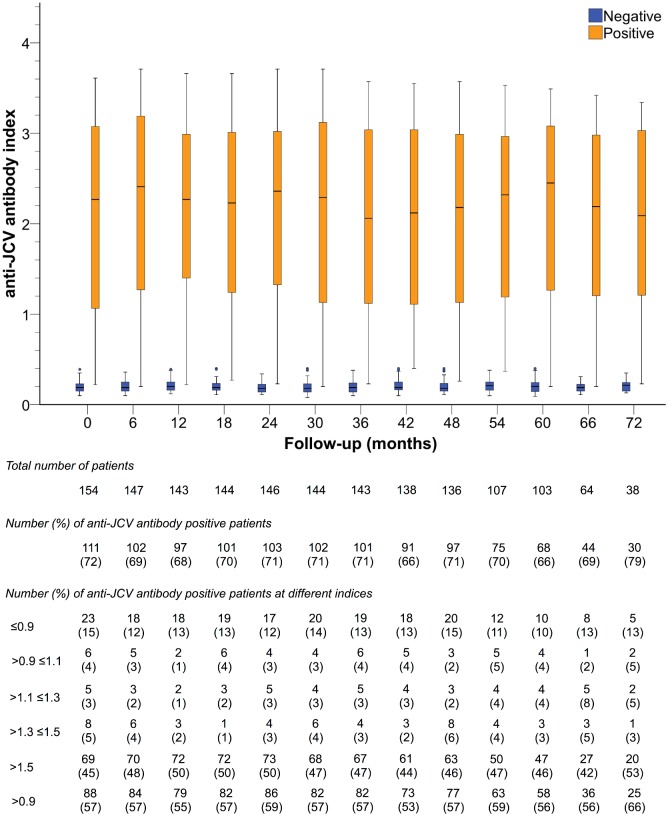
Evolution of anti-JCV antibody index.Anti-JCV antibody indices are displayed in seronegative and seropositive patients at the different time points during follow-up. At each visit, the total number of patients, the number of anti-JCV antibody positive patients and their distribution among different index categories are shown. JCV, John Cunningham virus.